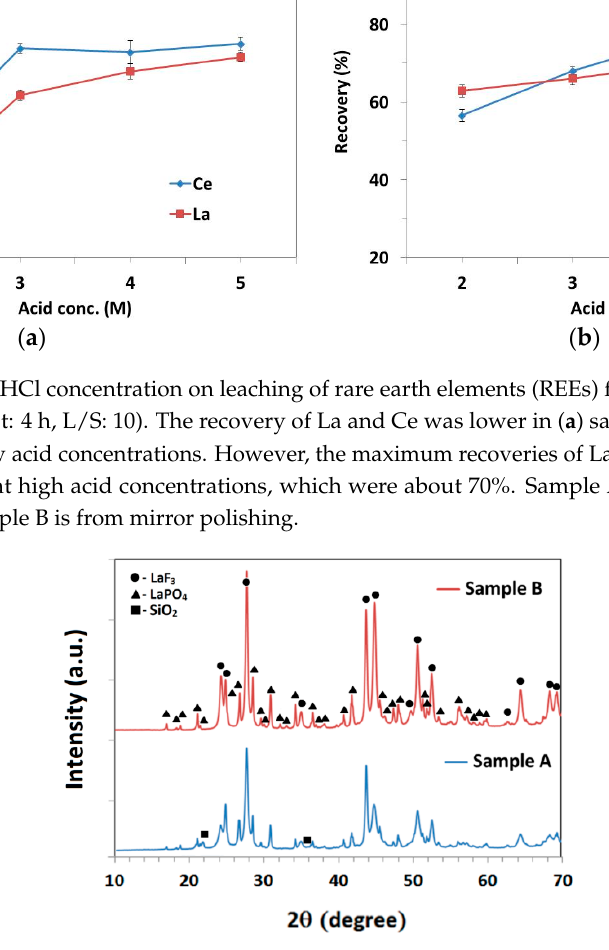
Figure 8. Flowsheet for complete recovery of REEs from polishing waste by acid-based process. This flowsheet shows that polishing waste was treated by acid leaching followed by alkali treatment. 3.5. Alkali-based process As explained earlier, it is difficult to completely recover REEs from polishing waste only by acid leaching. Therefore, in an alternative approach, alkali treatment of the polishing waste was carried out to convert acid insoluble compounds to acid-soluble compounds. Figure 9 shows the flowsheet for an alkali-based process for complete recovery of REEs from glass polishing waste. Alkali treatment of polishing waste converts oxyfluorides and phosphates to oxide/hydroxides of REEs according to the following reactions: REOF + NaOH = NaF + RE 2 O 3 /REO 2 /RE(OH) 3 + H 2 O (3) REPO 4 + NaOH = Na 3 PO 4 + RE 2 O 3 /REO 2 /RE(OH) 3 + H 2 O (4) The waste samples were roasted with two different ratios of NaOH at 500 °C for 4 h. After alkali treatment, the roasted samples were washed with water at 60 °C for 1 h to dissolve NaF, Na 3 PO 4 and other water-soluble compounds. NaOH, NaF and Na 3 PO 4 can be recovered from the solution by